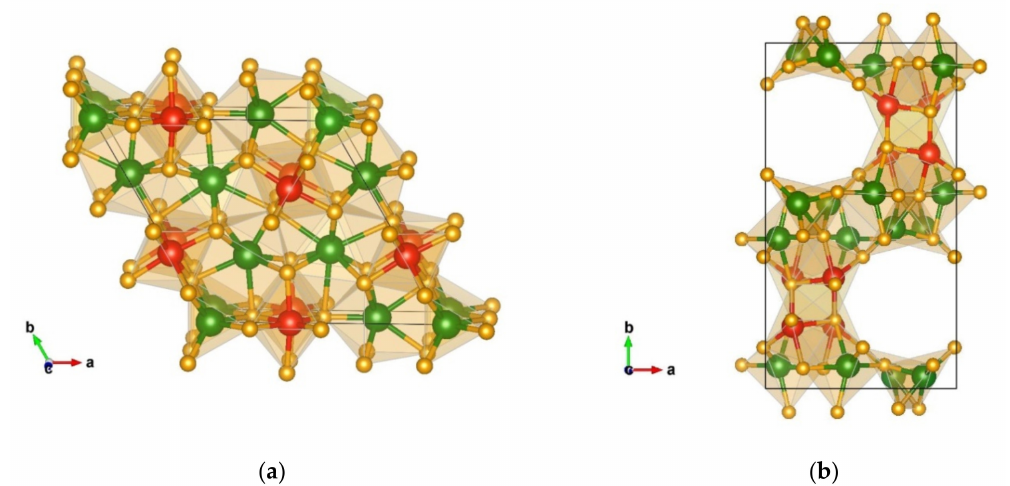
Figure 8. Visualization of non-favorable Cr 2 SiN 4 modifications obtained from data-mining: ( a ) Ca 2 IrO 4 -type in space group P-62m (no. 189); ( b ) CaB 2 O4-type in space group Pccn (no. 56). Green, red, and yellow spheres denote Cr, Si, and N atoms, respectively.